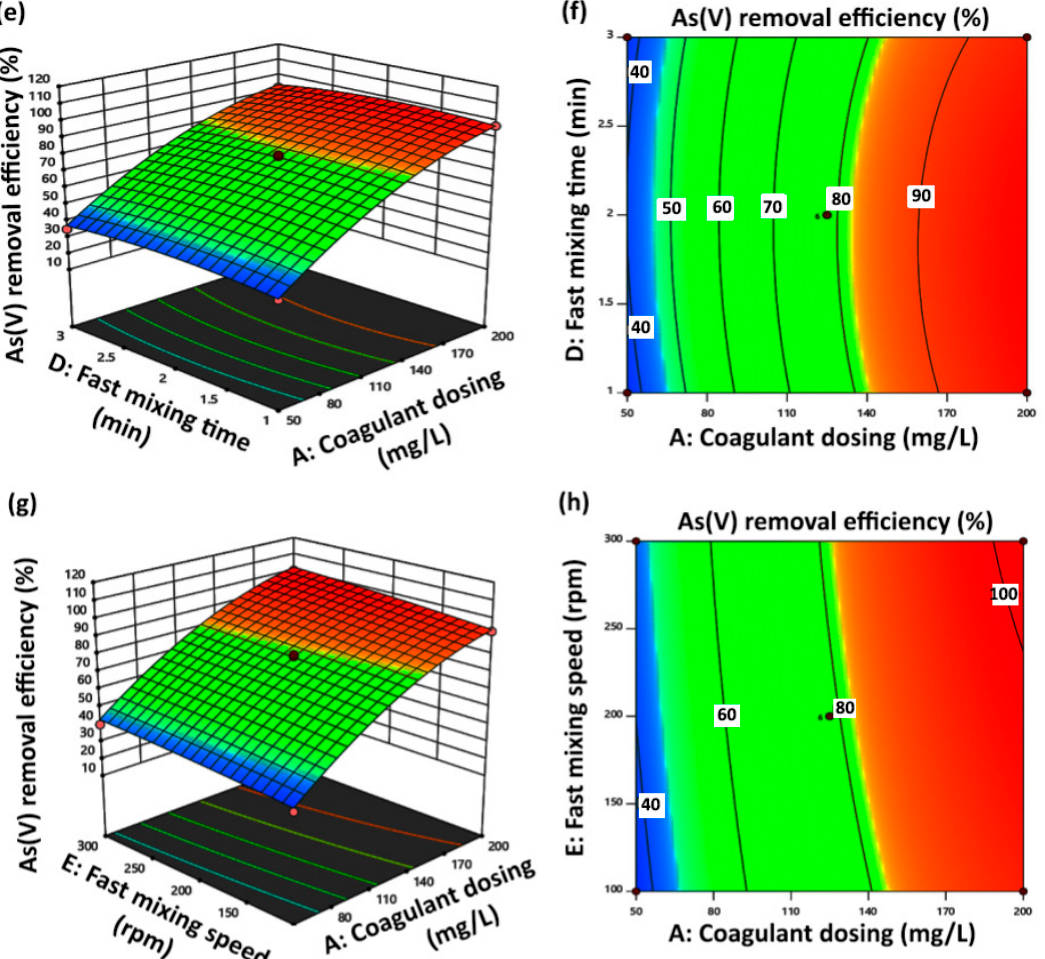
Figure 2. Three-dimensional surface and two-dimensional contour plots of As(V) removal. ( a , b ) show the effect of coagulant dosing (mg/L) and co-coagulant dosing (mg/L); ( c , d ) show the effect of coagulant dosing (mg/L) and pH; ( e , f ) show the effect of coagulant dosing (mg/L) and fast mixing time (min); ( g , h ) show the effect of coagulant dosing (mg/L) and fast mixing speed